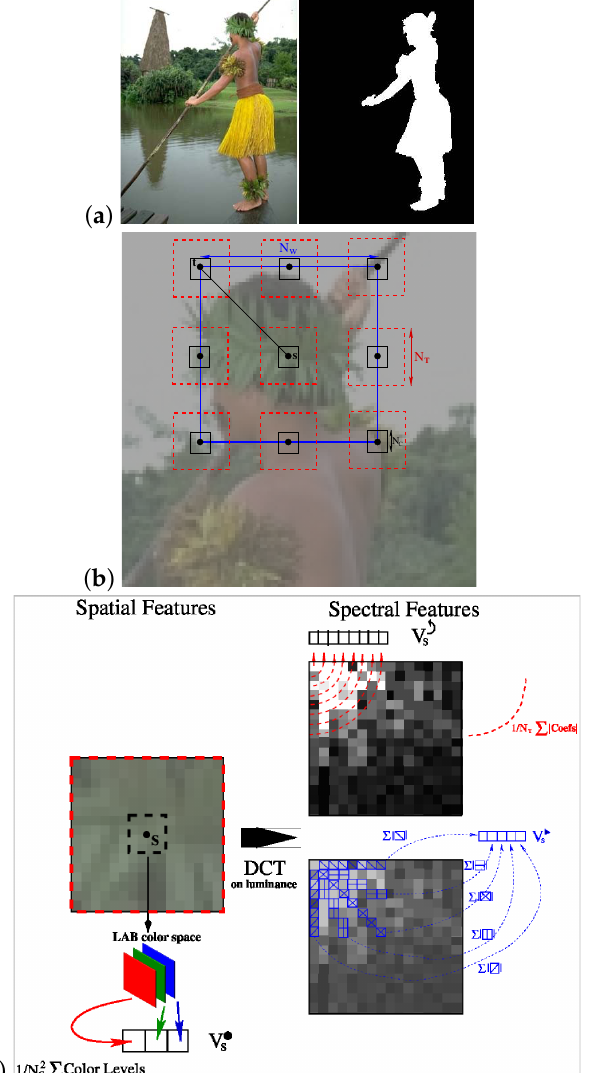
Figure 1. From top to bottom. ( a ) Input (and first) image of the DB-ECSSD database [21,68], assumed to be toroidal and showing a salient object and its ground truth. ( b ) Subsample G s of 8 pairs of pixels < s , t > associated to each pixel s (in which the pixel t is evenly located all around an N w × N w square window (with N w = 50 in our case) with the two local square subwindows associated to each site s (cid:97) (cid:73) or t . ( c ) The spatial and spectral feature vectors V • s , V s and V s were built from the two local squared subwindows associated to the site s